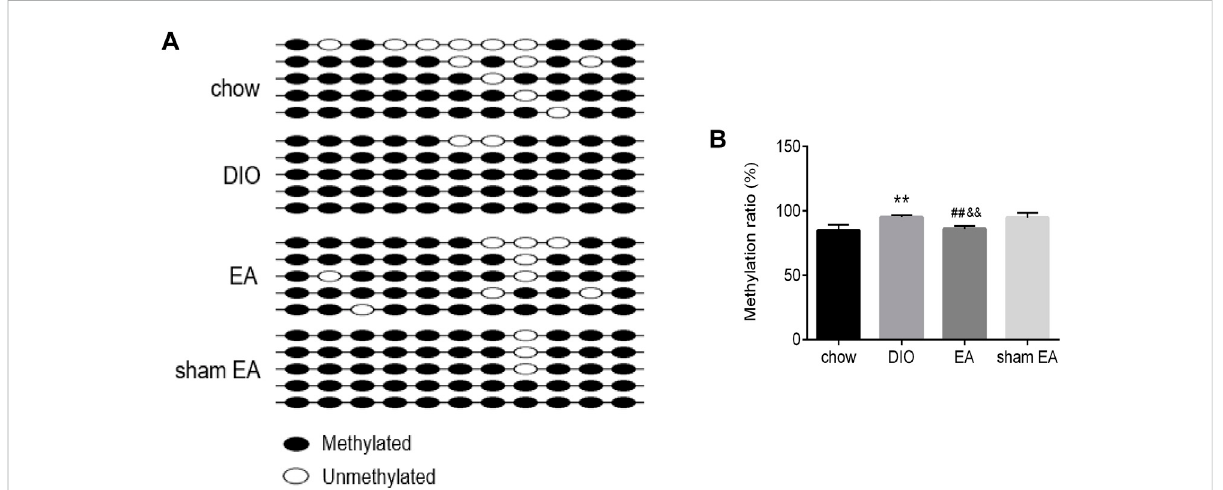
FIGURE 6 EA treatment decreased the methylation rate of TSC1 gene promoter in the hypothalamus. (A) Lollipop-style representation of methylated/ unmethylated sites of TSC1 gene promoter; (B) the methylation ratio of TSC1 gene promoter detected by BSP analysis. All data are expressed as Mean ± SD ( n = 5 rats per group), ** p < 0.01 vs. chow; ## p < 0.01 vs. DIO; && p < 0.01 vs. sham EA. BSP, Bisul fi te Genomic Sequence; EA, electroacupuncture; DIO, diet-induced